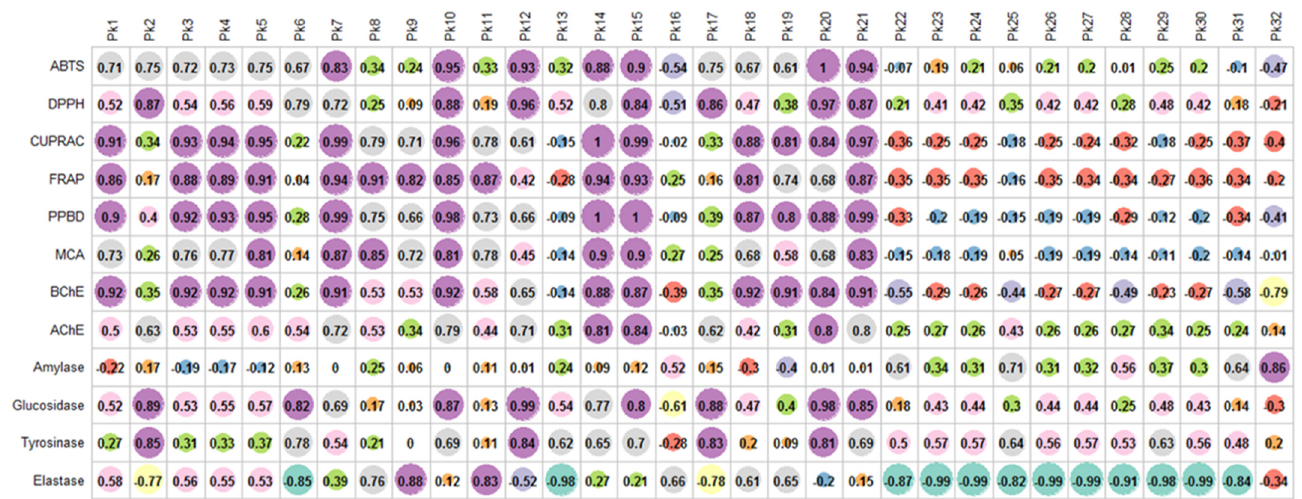
Figure 2. Relationship between phytochemical compounds and antioxidant and six key enzyme inhibitory activities.